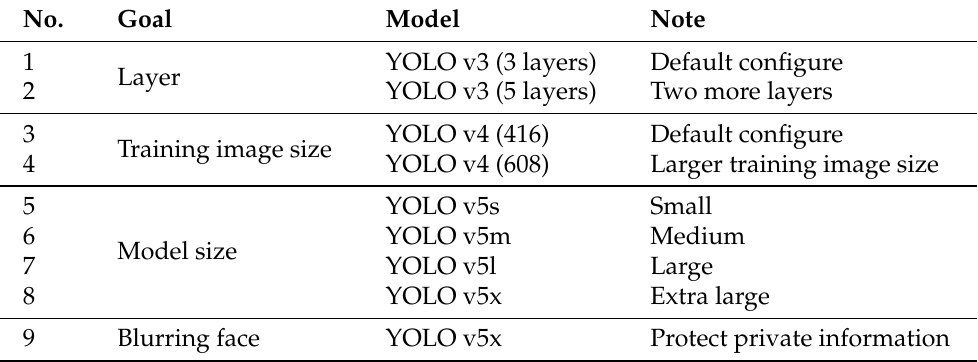
Figure 6. Number of instances in each scale category (calculated on resizing each image to 408 × 408). Table 1. Experimental goals (one YOLO version for one